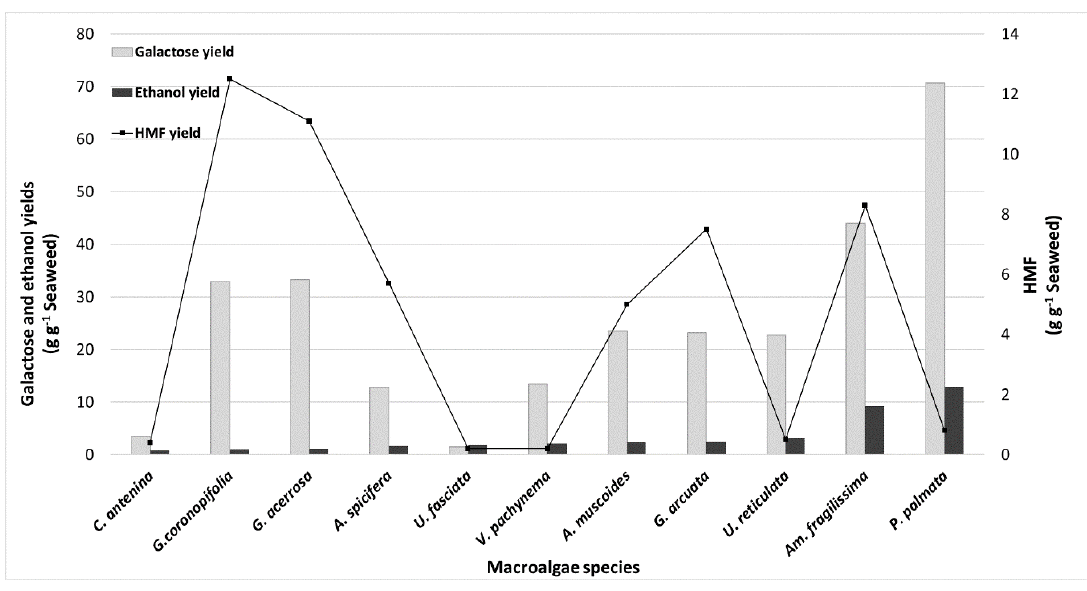
Figure 3. Galactose, 5-hydroxymethyl furfural (HMF), and ethanol yields from different seaweed species using data from Mutripah et al. (2014) [135].